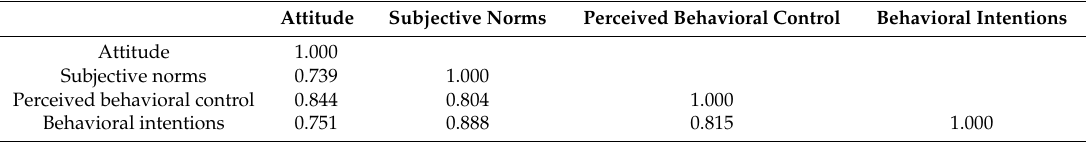
Table 10. Pearson’s correlation matrix (mean).